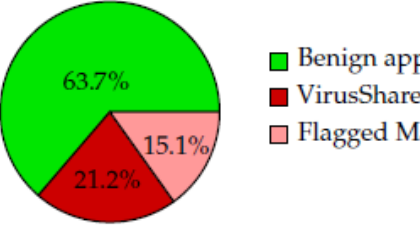
Figure 3. Dataset